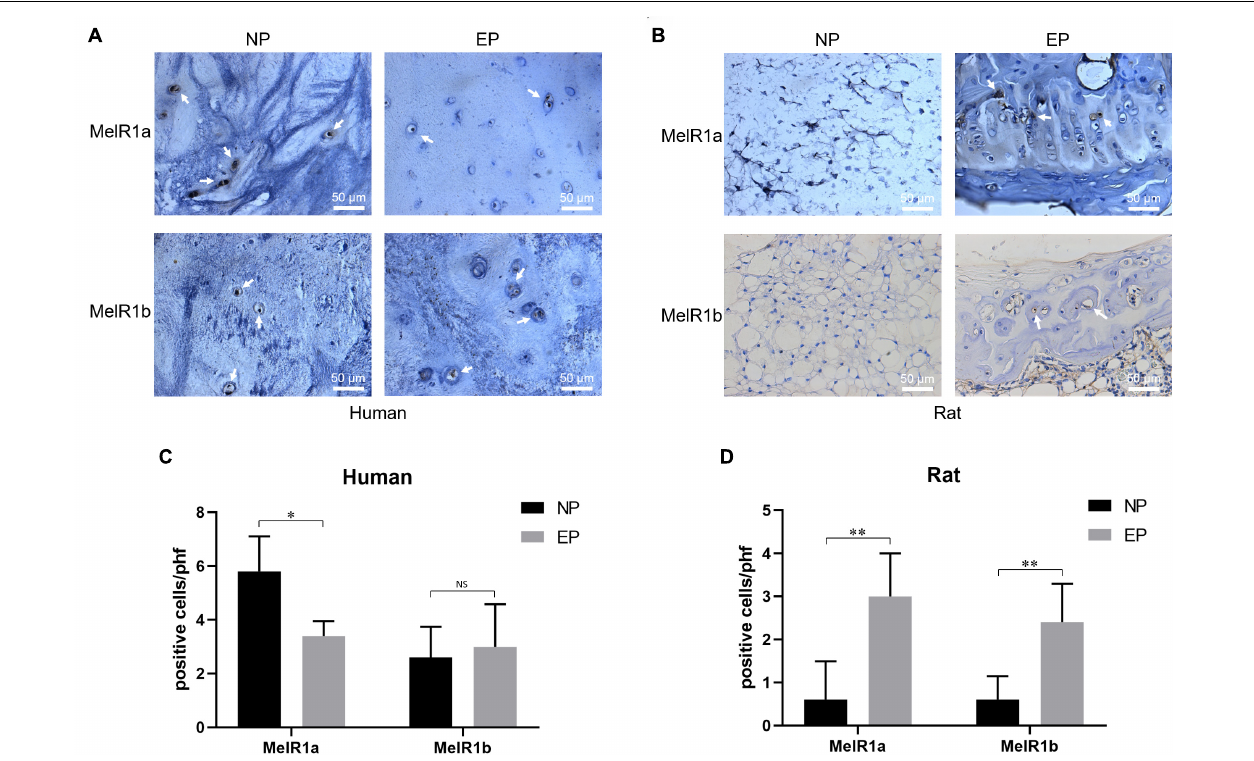
FIGURE 4 | Immunohistochemical staining of melatonin (Mel) receptors 1a and 1b. (A) Mel receptors 1a and 1b were both expressed on nucleus pulposus (NP) and endplate (EP) of humans. (B) Mel receptors 1a and 1b were only expressed on EP rather than NP of rats. (C) Quantitation of Mel receptors 1a and 1b-positive cells in humans. (D) Quantitation of Mel receptors 1a and 1b-positive cells in rats [ n = 5, no significant difference (NS), ∗ P < 0.05, ∗∗ P <